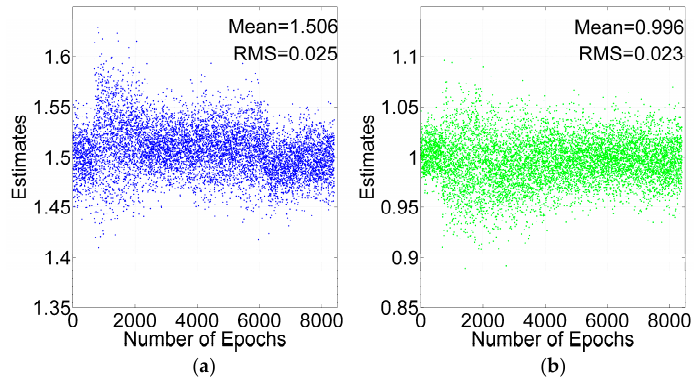
Figure 10. Cycle slips estimates for GPS: 1.5 Cycles ( a ); 1 Cycle ( b ).